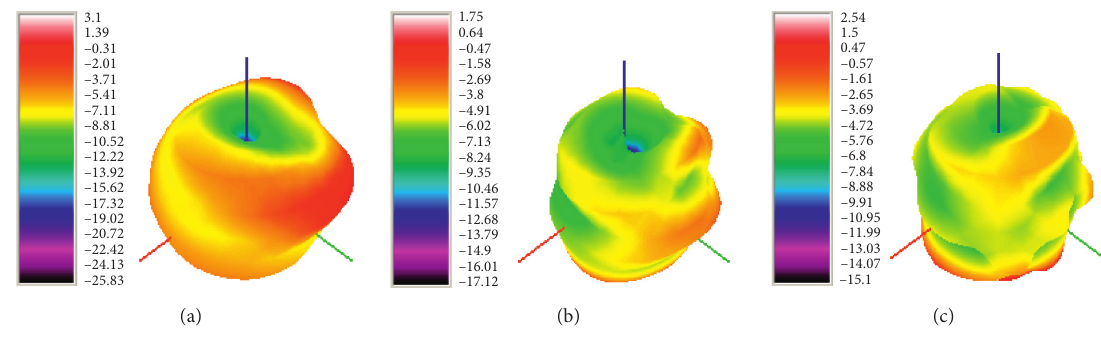
Figure 10: Measured 3D radiation patterns: (a) 1.57GHz, (b) 2.15 GHz, and (c)